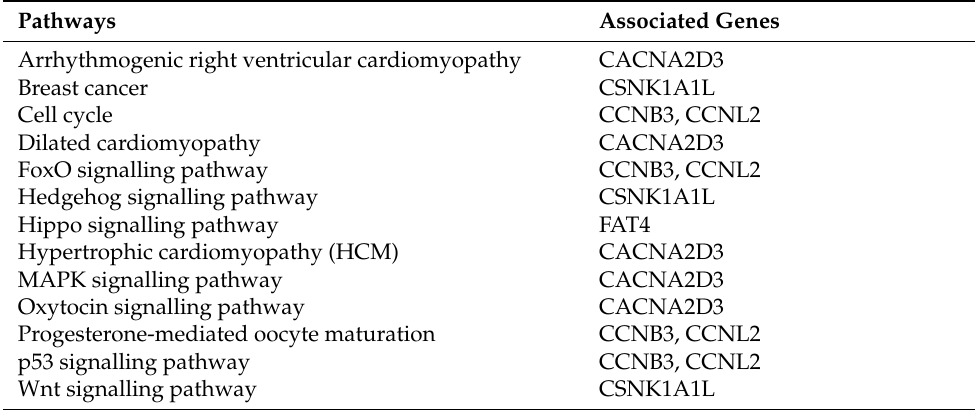
Figure 7. Biological pathways associated with BPA-dysregulated genes in humans. ( a ) Human- disease-associated pathways. ( b ) Environmental information processing pathways. ( c ) Cellular- processes-associated pathways. ( d ) Endocrine-system-associated pathways. ( e ) Venn diagram pre- senting the common pathways in KEGG- and BPA-impacted pathways reported in CTD. Genes that affect each pathway are shown on the right corner of each block. Table 1. In existing literature, 13 common pathways have been previously described as being impacted by BPA exposure with associated DEGs from this